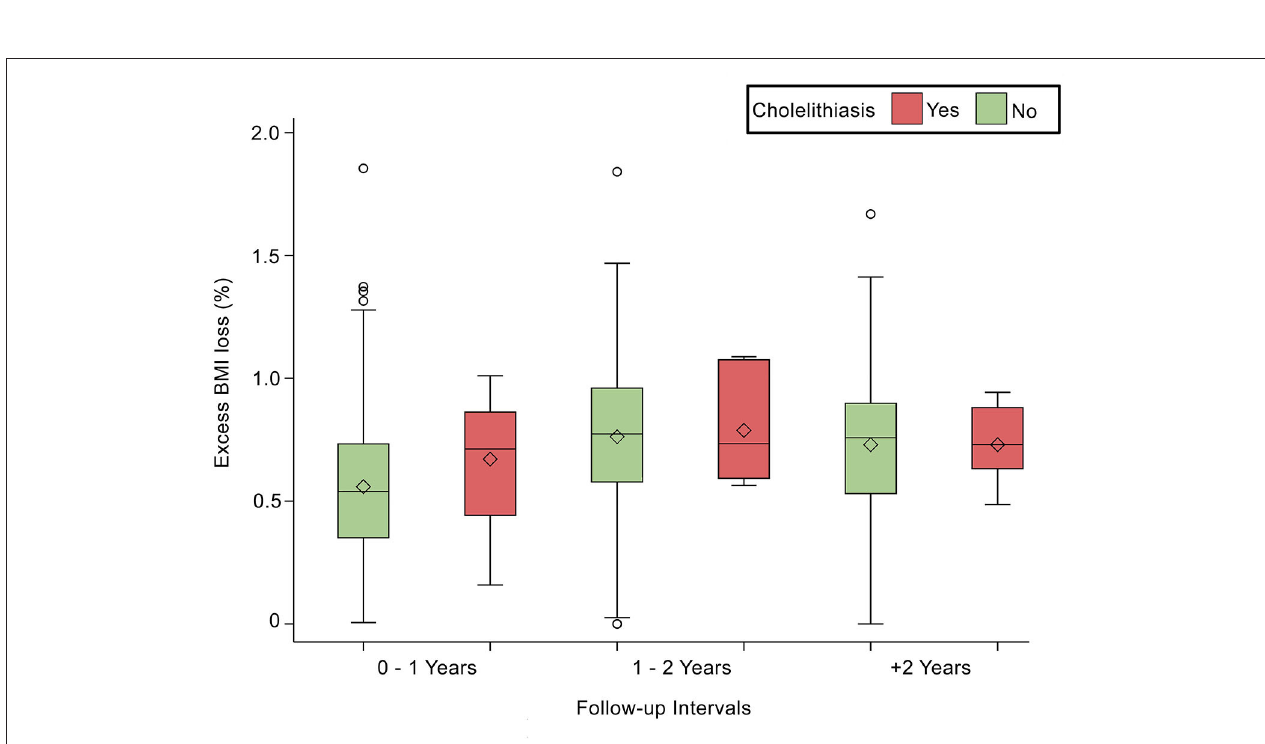
FIGURE 2 | Depicts the statistically significant relationship between Excess BMI loss (%) and follow-up intervals, p < 0.0001.